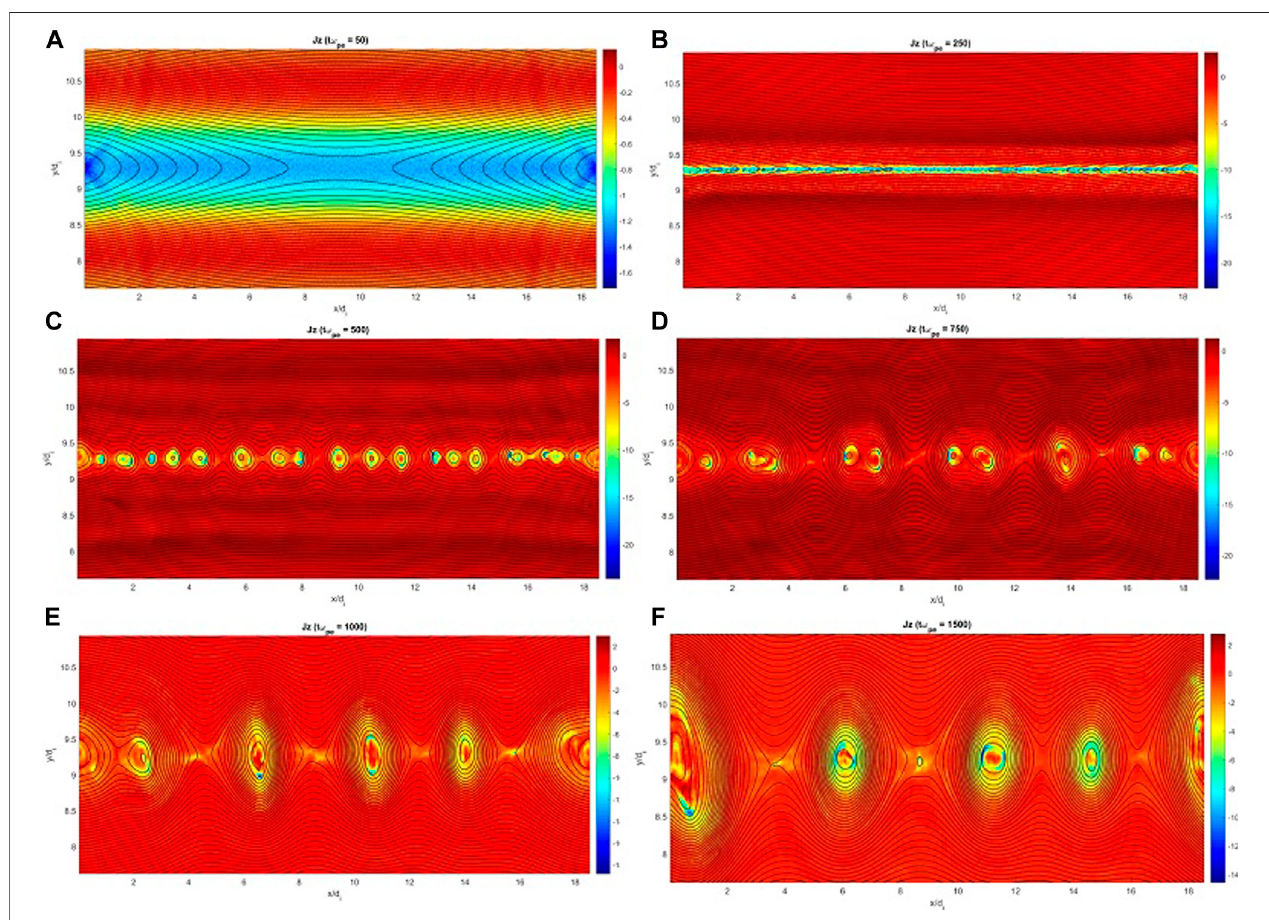
FIGURE 1 | Perpendicular component of the electric current density J z being superimposed by the magnetic fi eld lines at times: t ω pe (cid:1) 50 (A) , 250 (B) , 500 (C) . 750 (D) , 1,000 (E) , 1,500 (F) .